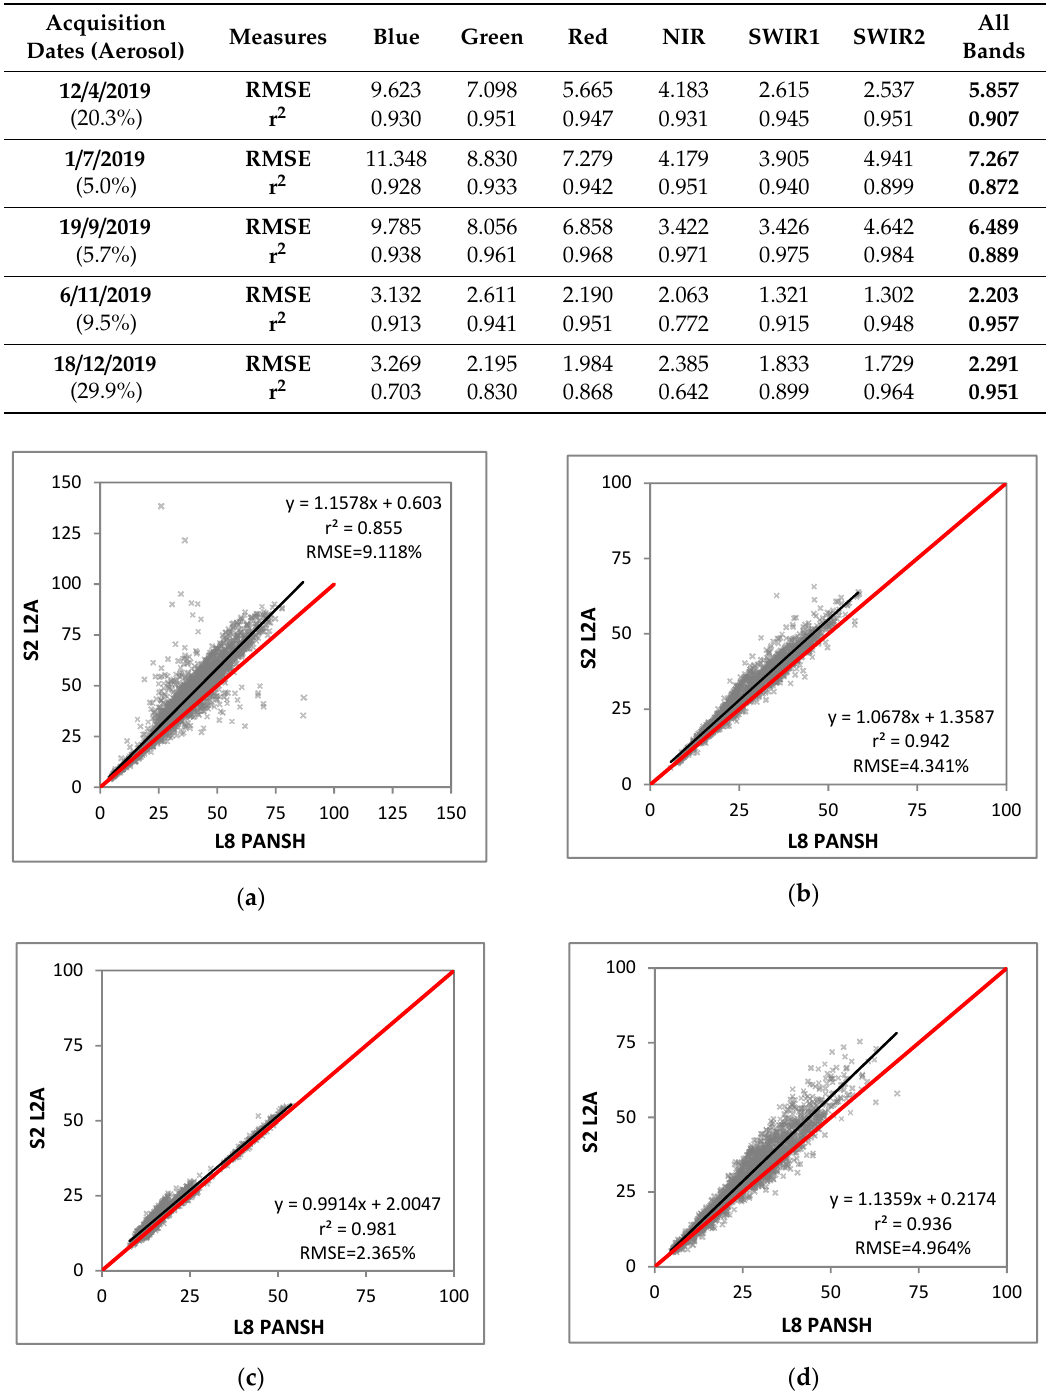
Figure 7. Correlation of all surface reflectance values between the six common bands of L8 PANSH and S2 L2A products, with n being the number of total data points per study site: ( a ) SS1 ( n = 3600); ( b ) SS2 ( n = 1800); ( c ) SS3 ( n = 1200); ( d ) SS4 ( n = 3000).